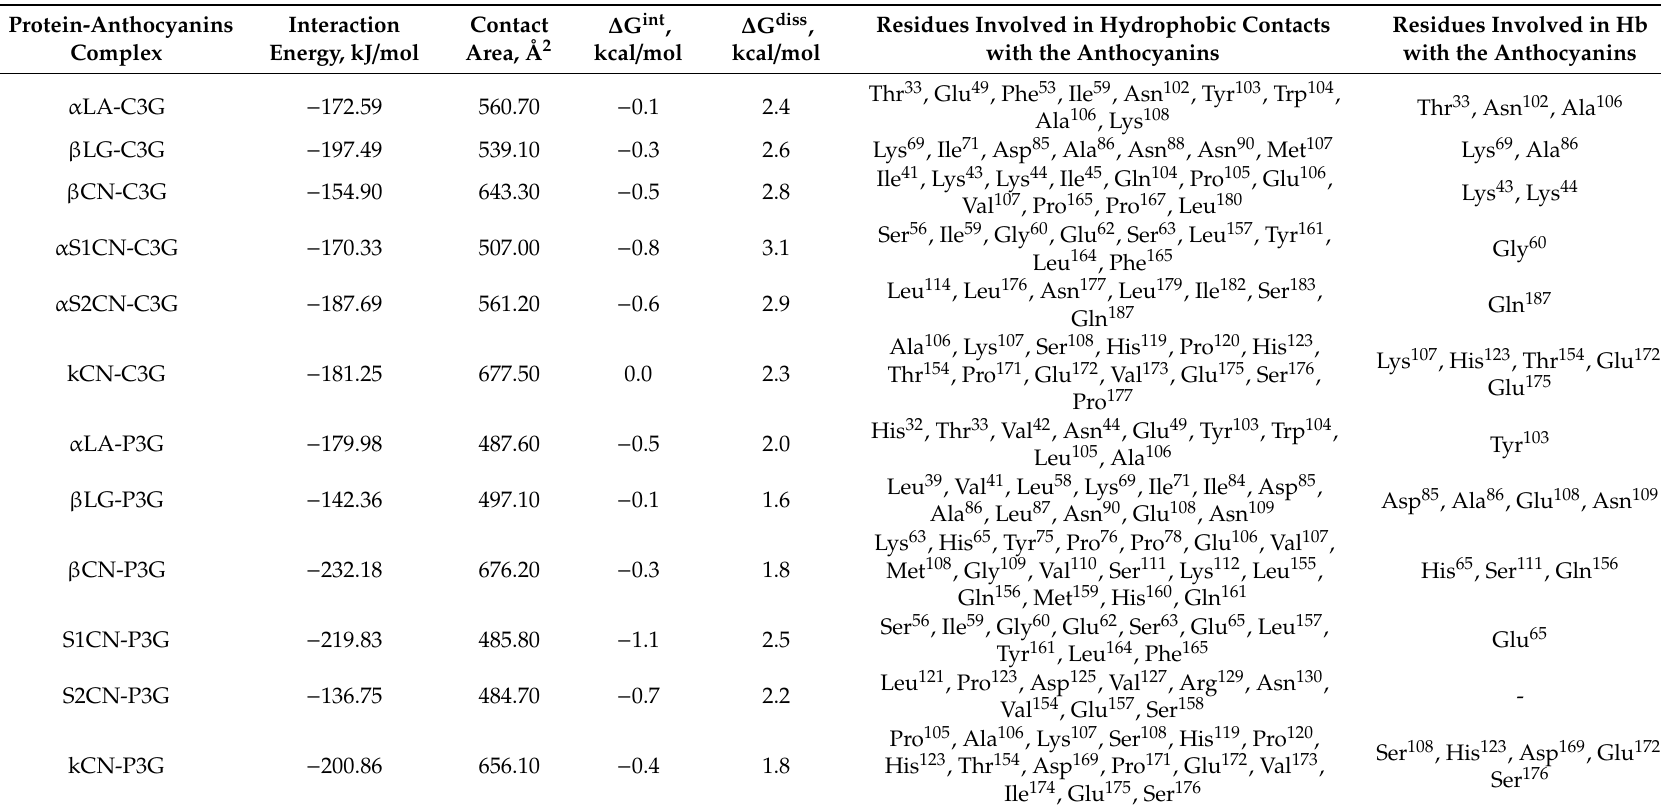
Table 1. Details on the interaction between milk proteins ( α LA- α -lactalbumin, β LG- β -lactoglobulin, alpha-S1 casein- α S1CN, alpha-S2 casein– α S2CN, beta casein β CN, and kappa casein-kCN) and main anthocyanins (cyanidin-3- O -glucoside and peonidin-3- O